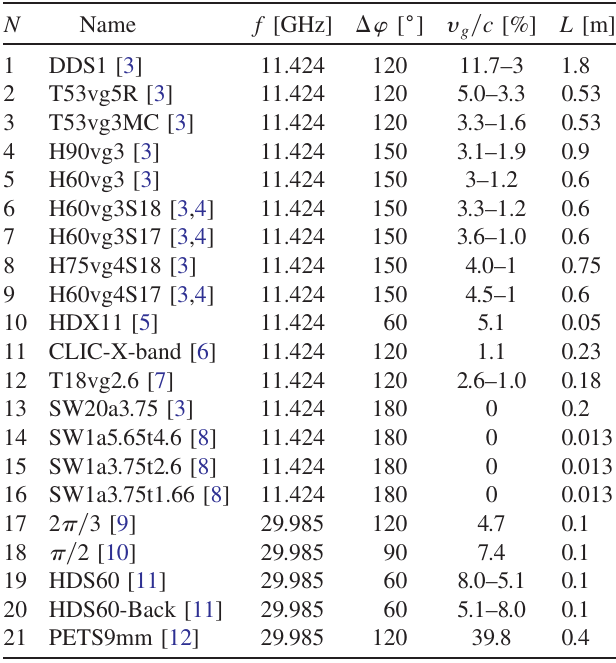
TABLE I. Structure parameters used in the analysis. From left to right: structure number used for identification later on in the paper, name with the reference, frequency f , rf phase advance per cell (cid:1) ’ , group velocity normalized to the speed of light =c , and structure length L v g